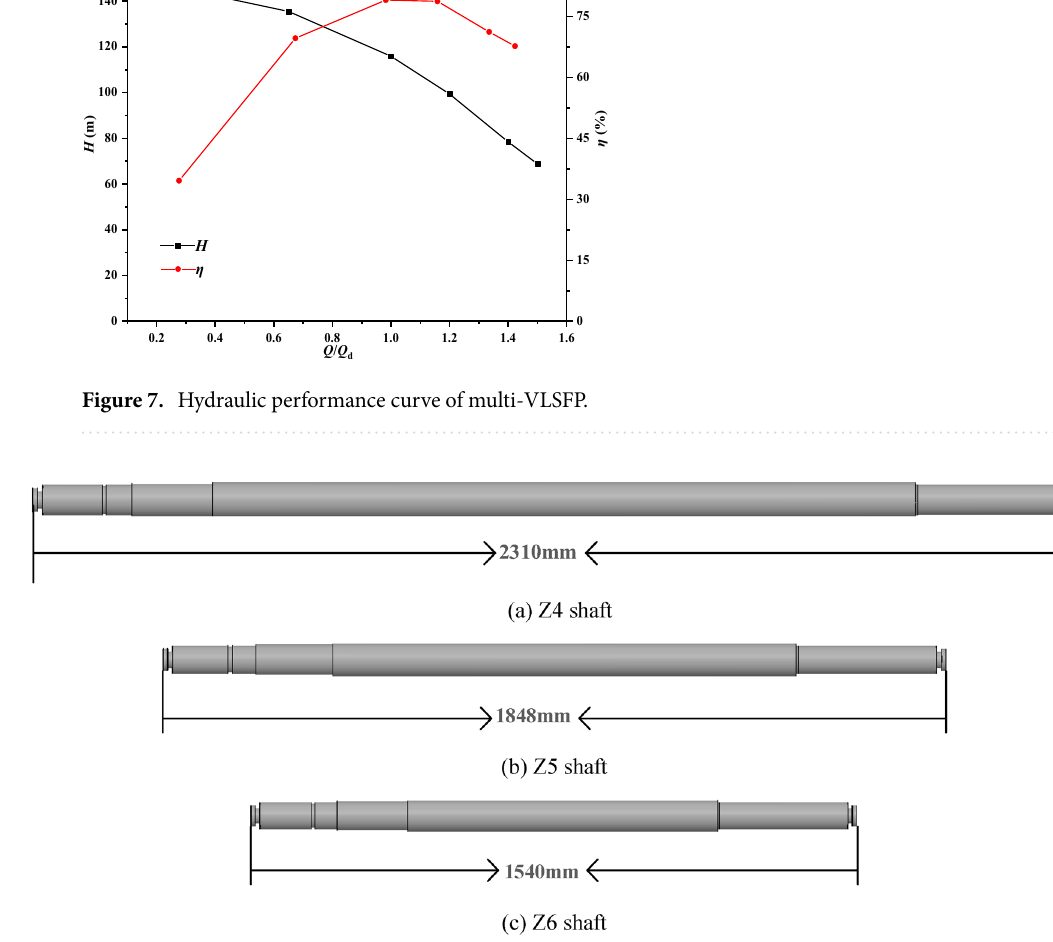
Figure 8. Three single-segment intermediate shafts: Z4, Z5 and